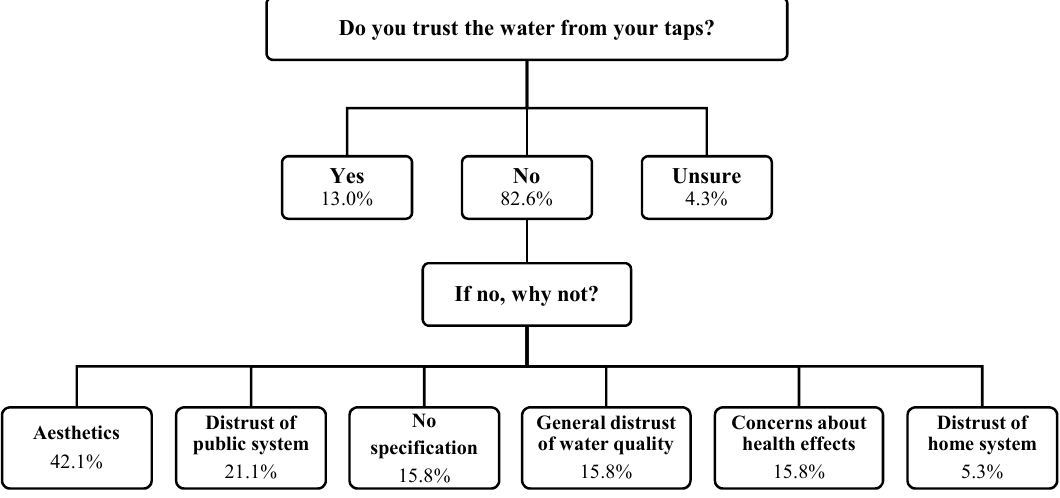
Figure 2. Study participant survey responses to questions regarding trust of in-home point-of-use tap water, categorized by common themes.